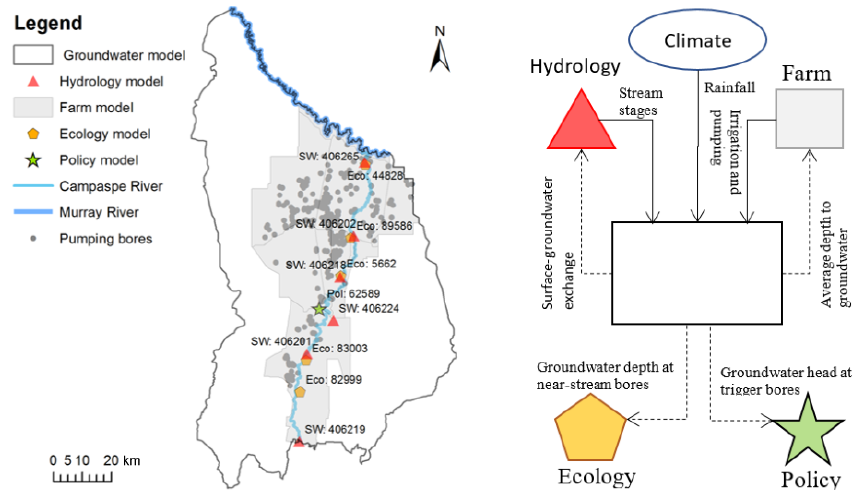
Figure 7. Groundwater model components and model area as well as points and interactions with other component models from the per- spective of the groundwater